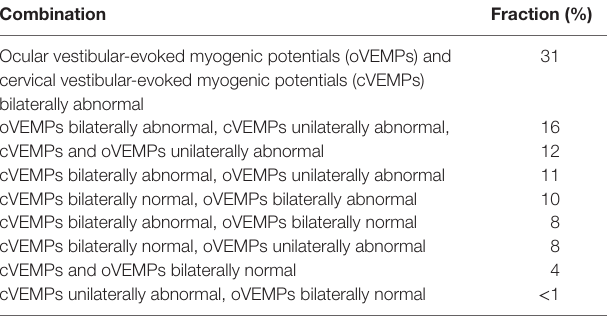
TaBle 6 | Distribution of utricular and saccular function in the bilateral vestibular loss patients ( n = 101).